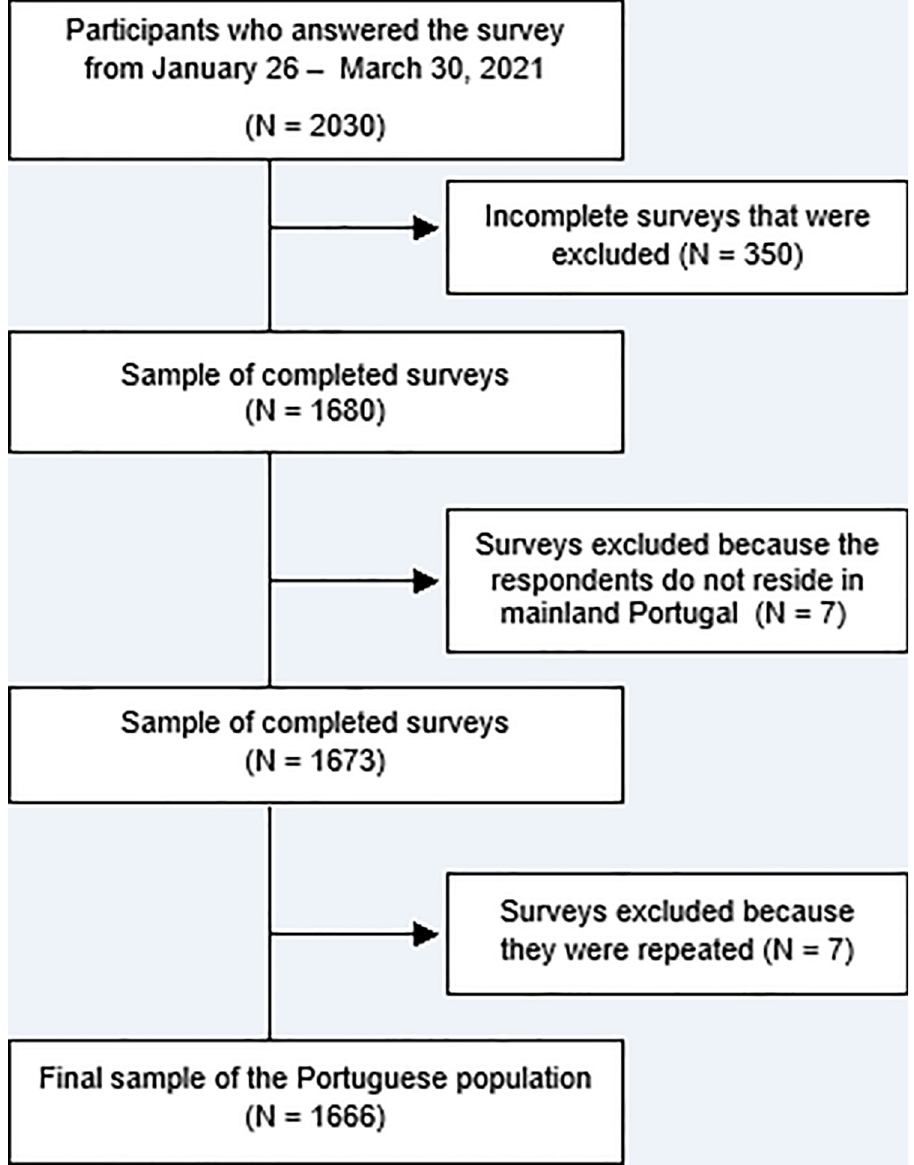
Fig 1. Flowchart of sampling process of the Portuguese